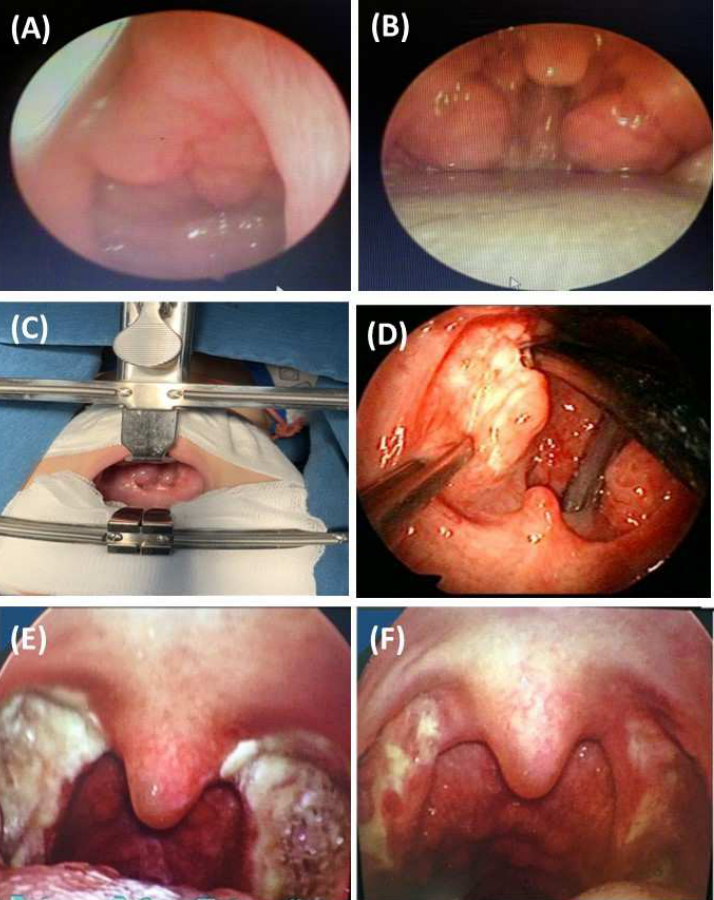
Figure 1. Tonsillectomy in children with OSA related to adenotonsillar hypertrophy. ( A ): adenoid hypertrophy; ( B ): tonsillar hypertrophy; ( C , D ): tonsillectomy; ( E , F ): the results of tonsillectomy at day 7 and 14 after intervention.